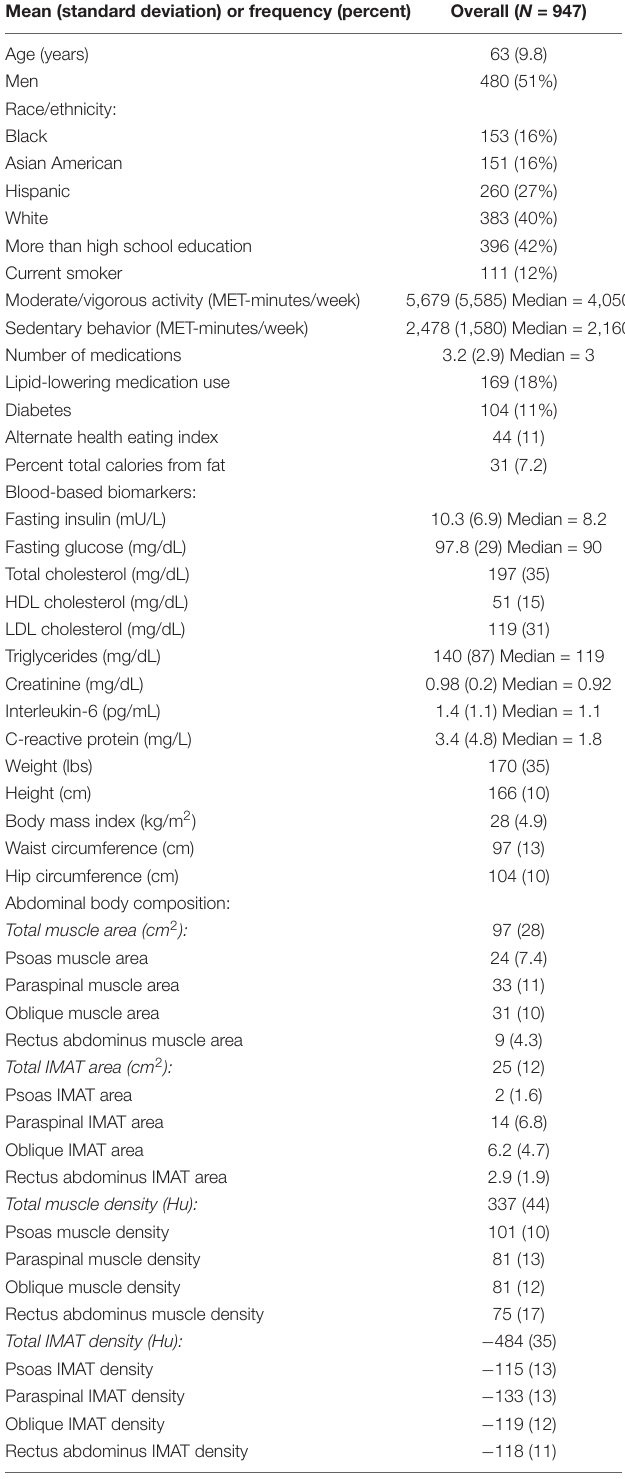
TABLE 1 | Study characteristics at visit 1 among 947 MESA